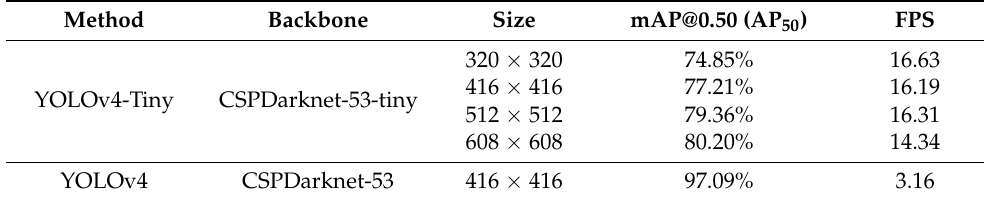
Table 1. Performances of YOLOv4-Tiny and YOLOv4 with respect to different resolutions.